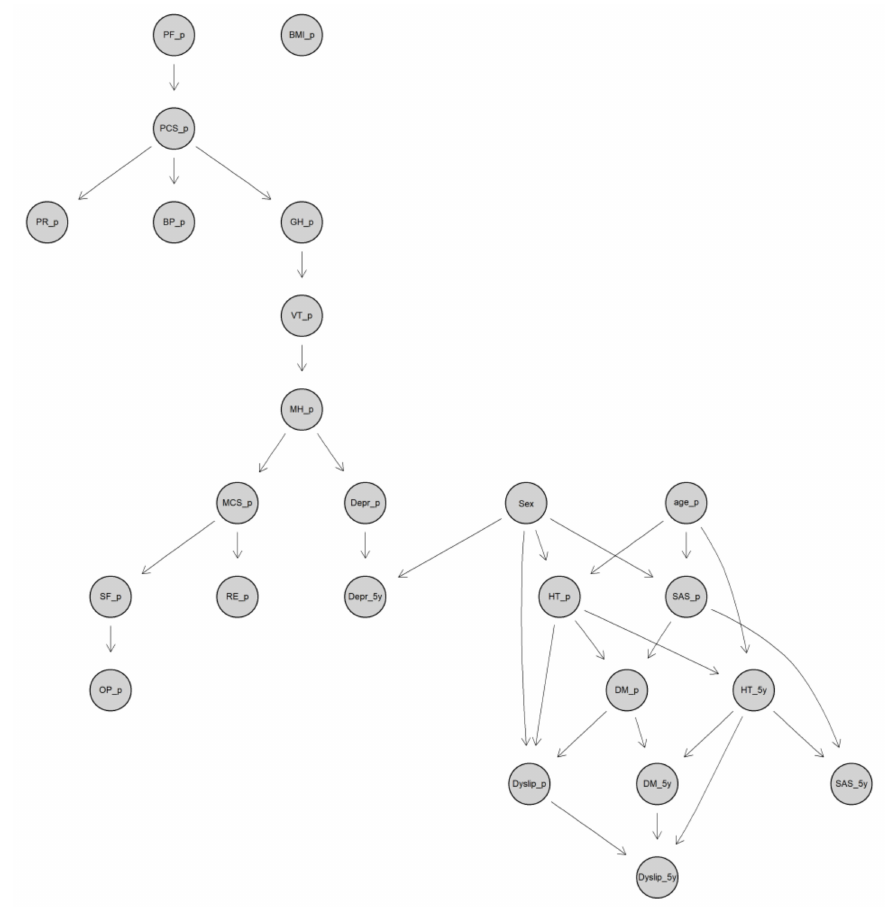
Figure 2. The DAG of the DBN for predicting postoperative 5-year comorbidities. DAG, directed acyclic graph; DBN, discrete Bayesian network; PF, physical functioning; RP, role physical; BP, bodily pain; GH, general health; VT, vitality; SF, social functioning; RE, role emotional; MH, mental health; PCS, summary physical scale; MCS, summary mental scale; OP, obesity-related problems; BMI, body mass index; SAS: sleep apnea syndrome; HT, hypertension; DM, diabetes; Depr, depression; Dyslip, dyslipidemia; _p, preoperation; _5y,